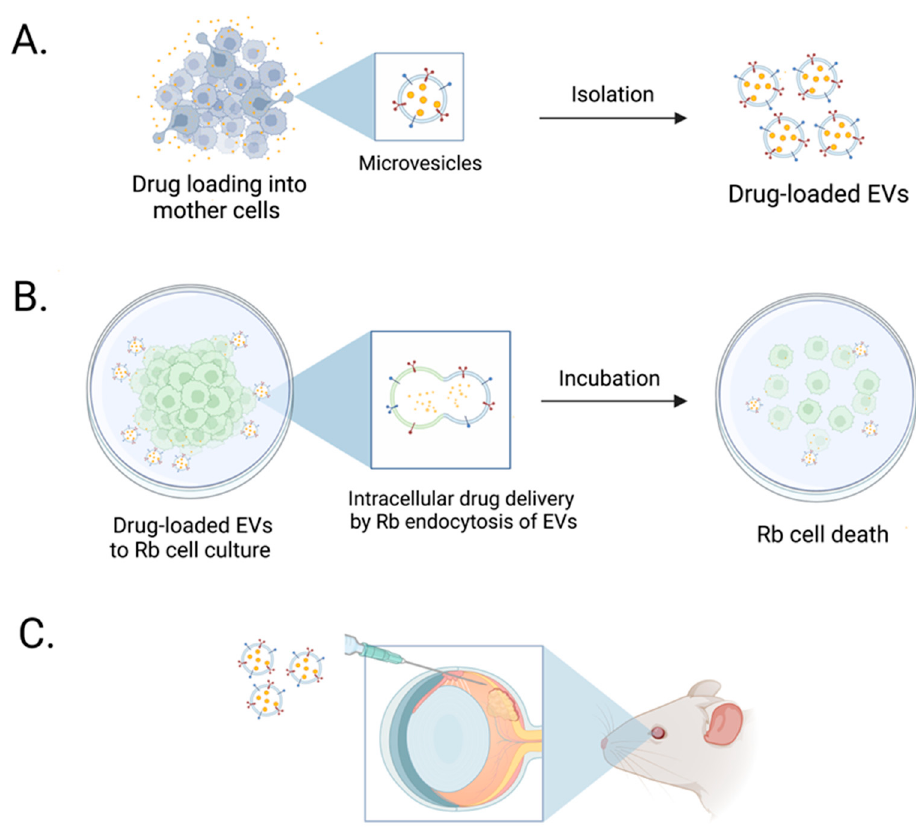
Figure 6. Schematic illustration of Dox-loaded EVs enhancing in vitro retinoblastoma cell death. ( A ) 4T1 and SKBR3 Dox-loaded EVs were isolated and characterized for the quantity of loaded Dox. ( B ) Dox-loaded EVs were added to retinoblastoma cell cultures in vitro and enhanced tumor cell death in Dox-loaded EVs compared to freely added drug. ( C ) Future studies will focus on assessing targeted drug delivery of Dox-loaded EVs in retinoblastoma tumor in in vivo models. Multiple cytotoxicity studies were carried out and we found that Dox-loaded EVs caused more tumor cell death than free Dox. EVs have been reported to exhibit strong cellular endocytic activity, which may explain their potential for drug delivery to Y79 cells. To investigate this concept, the endocytic capacity of EVs by Y79 cells was tested in vitro to demonstrate the potential of 4T1 and SKBR3 EVs to enter retinoblastoma cells. In Y79 cells, we found that a substantially higher proportion of breast cancer EVs were en- docytosed than non-cancerous ocular epithelial EVs. We propose that the accumulation of breast cancer EVs is related to the molecular composition of surface markers [64,65], which increases their capacity to become endocytosed compared to non-cancerous EVs. EV membrane proteins could include tetraspanins, integrins, or heparin sulfate proteo- glycans; these may trigger increased cellular uptake by Y79 cells and mediate changes in signaling cascades [80–82]. There is also evidence that breast cancer cells that express spe- cific markers would produce EVs [83–85] that can be internalized by Y79 cells via ligand- specific internalization, enhancing internalization and leading to increased cytotoxicity, which explains the efficiency of our Dox-loaded EV model. A culmination of different studies has reported the importance of membrane EV proteins in internalizing intrinsic EV cargo by targeted cells since they govern various tumor processes within the tumor microenvironment, including apoptosis, growth, inflammation, angiogenesis, invasion, and metastasis [86–91]. It is possible to hypothesize that breast cancer EVs are primed to target tumor cells and that the expression of key proteins could effectively deliver drugs